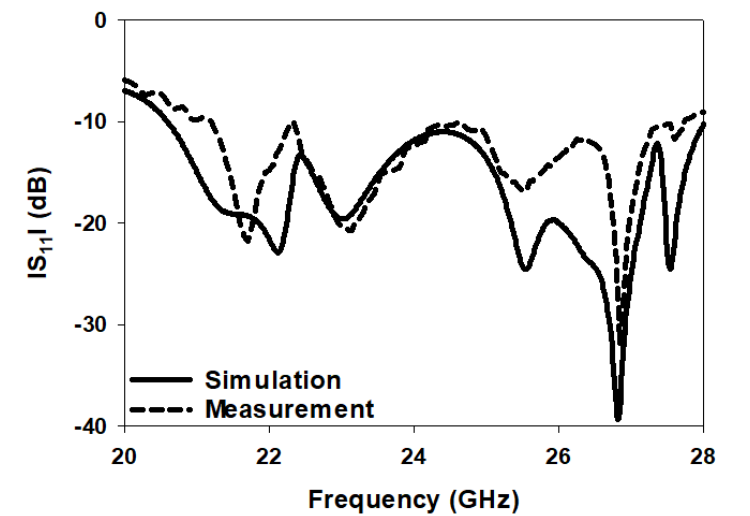
Figure 12. The S 11 of a hemispherical DRA placed on a grooved ground plane.